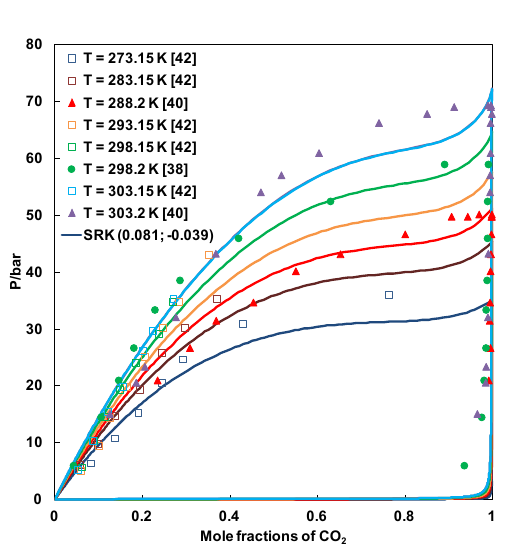
Figure 2. Comparison of new experimental data and literature data for the carbon dioxide + 2-methyl-1-propanol (isobutanol) system and calculations by SRK model: symbols, new data and literature data at different temperatures; solid lines, predictions by SRK ( k = 0.081, l = -0.039). 12 12